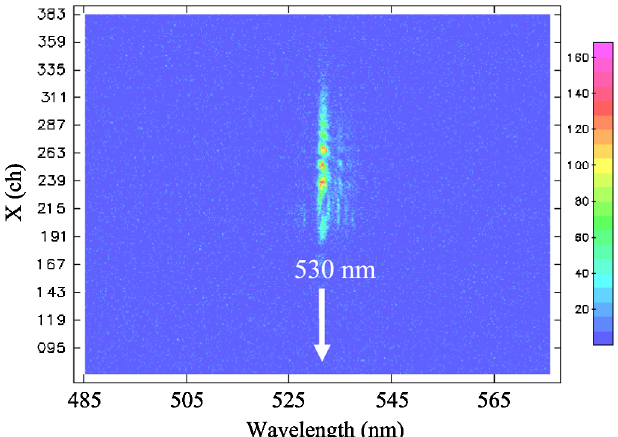
FIG. 15. (Color) An example imaging spectrometer image of undulator radiation sampled after undulator 6 with the 300-A beam from December 20, 2001. Localized spatial spikes are evident on the vertical display axis which is the x spatial